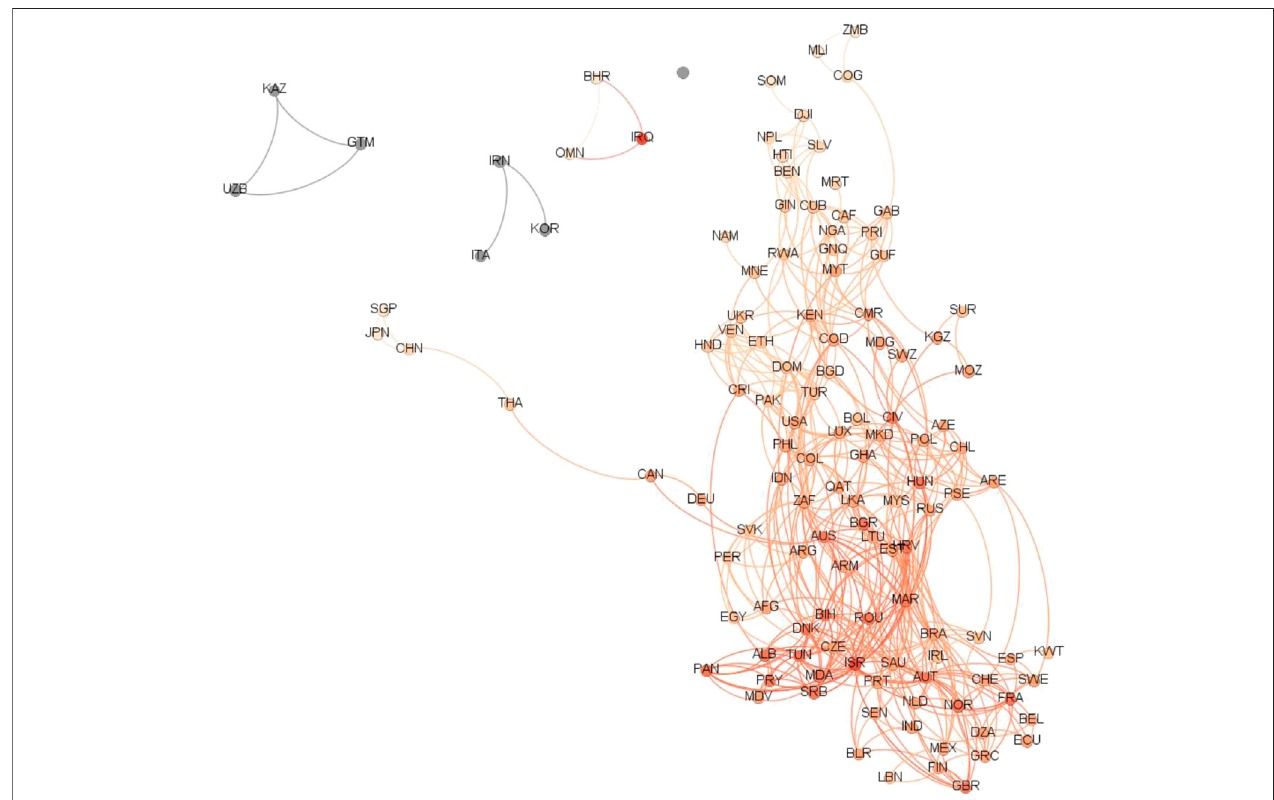
FIGURE 1 | The global COVID-19 pandemic network. Note: This is the global COVID-19 pandemic network. It excludes countries with fewer than 2,000 infected people. When the correlation of the growth rate of infected people is larger than 0.4, there is a connected edge between countries.